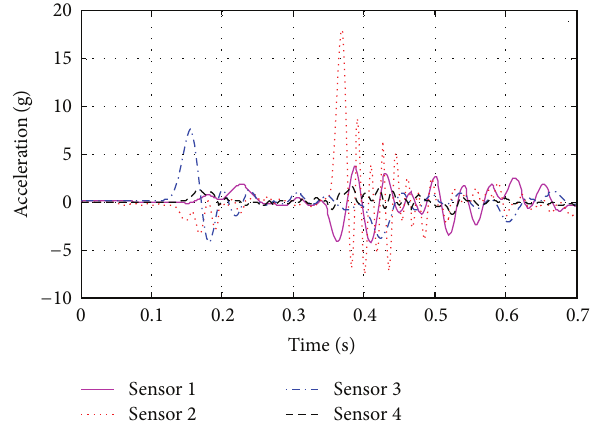
Figure 14: Accelerations with 𝑉 𝑦 = 1.17 m/s, 𝑉 𝑥 = 0 m/s, and 𝜃 = 10 ∘